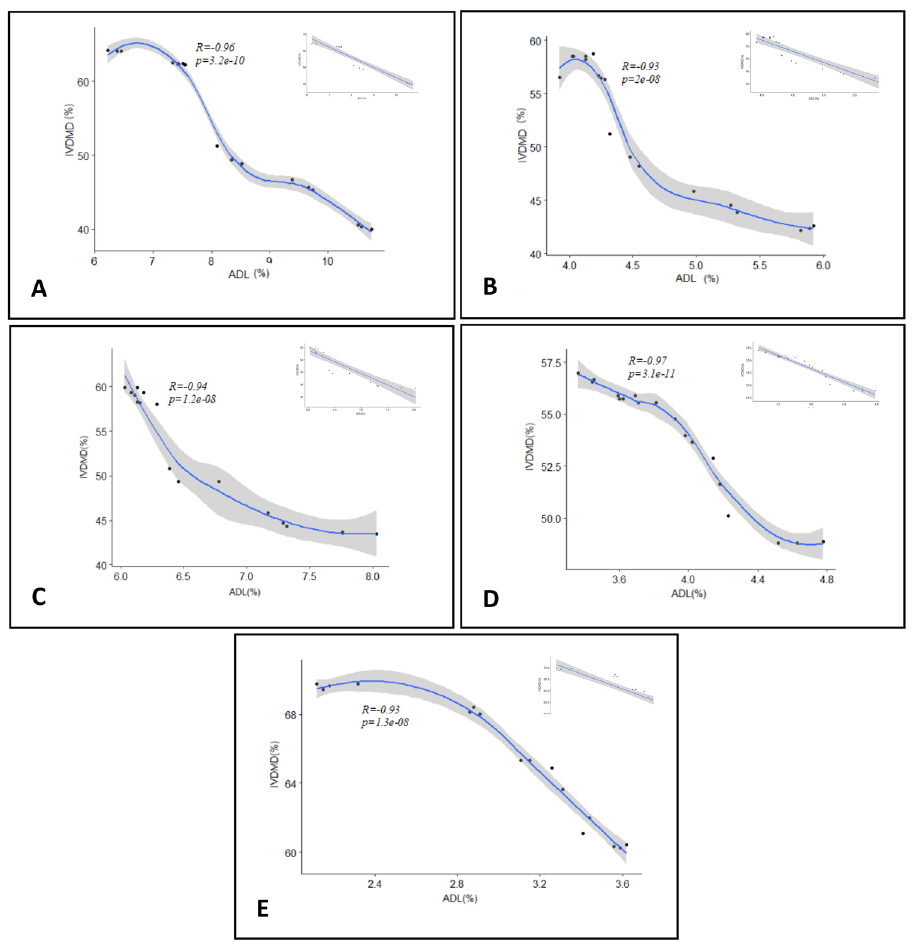
Figure 3. Correlation of acid detergent lignin (% ADL) to in vitro digestibility of dry matter (% IVDMD) of laccase treated crop residues ( A ) finger millet ( B ) paddy ( C ) wheat ( D ) maize and ( E ) sorghum Insert: Linear Regression graphs to generate R